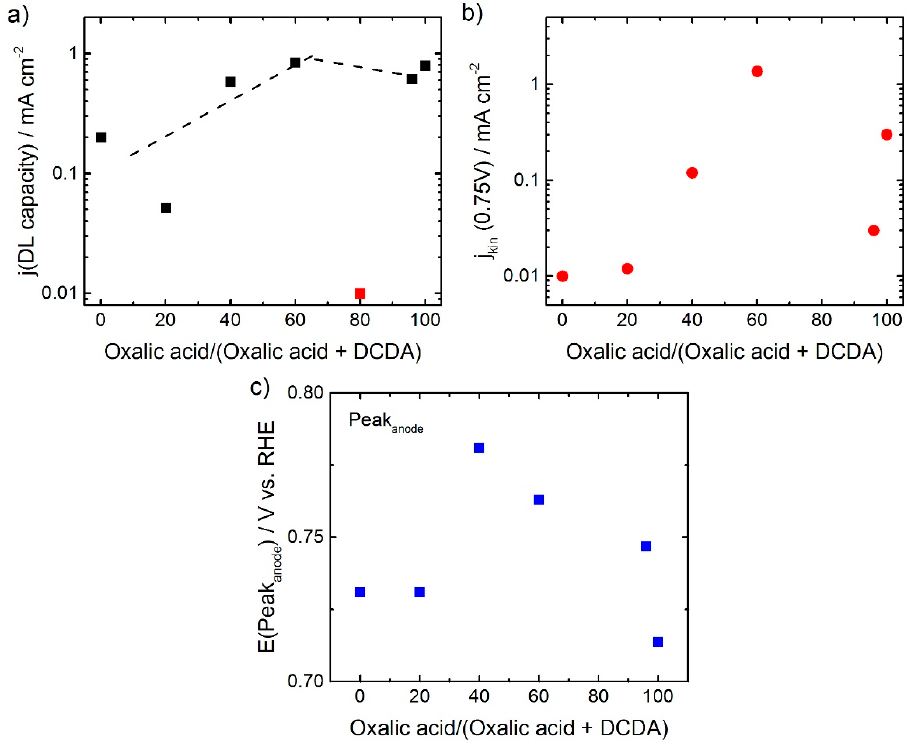
Figure 4. Analysis of electrochemical data. In ( a ) the current density related to the double layer capacity (100 mV s − 1 ) ( ■ ), outlier at 80% ( ■ ), in ( b ) the kinetic current density j kin ( ● ) and in ( c ) the potential positions of the peak maxima in the anodic sweep of the CVs are given as a function of the ratio of oxalic acid in SFA ( ■ ) .